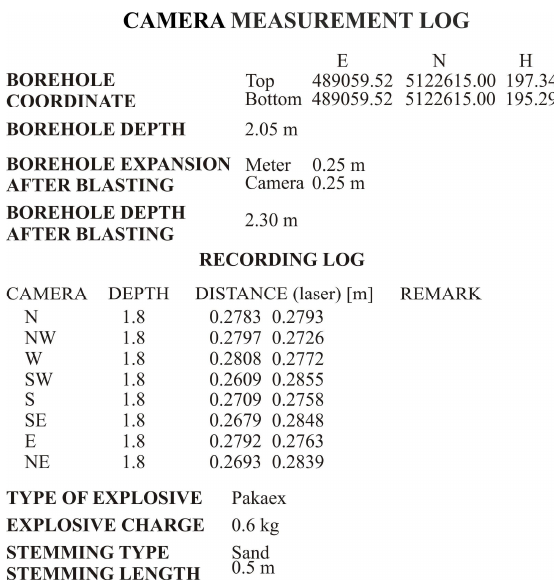
Figure 5. Report example [4].